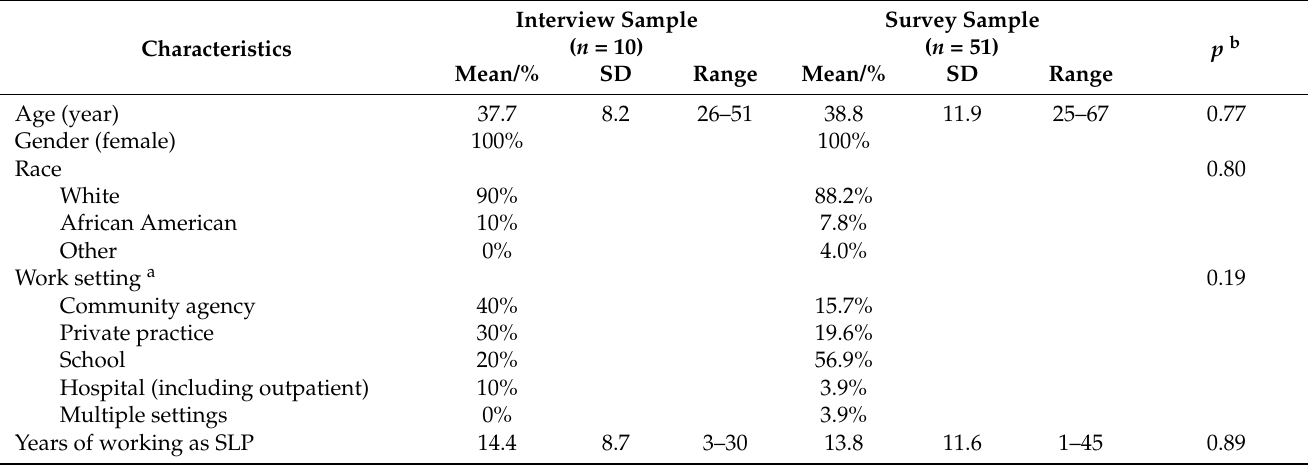
Table 1. Demographic information for the interview sample in July 2020 and the survey sample in December 2020.